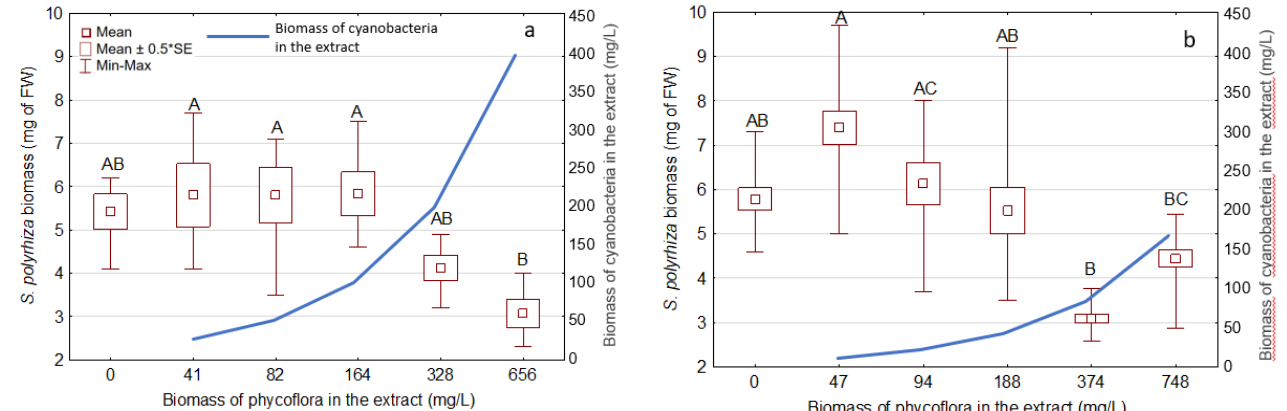
Figure 2. Effect of Phormidium extract ( a ) and Oscillatoria extract ( b ) on the fresh biomass of S. polyrhiza after 72 h exposure (means ± SE, n = 6, 0 = controls). Different uppercase letters (A, B, C) indicate statistically significant differences between treatments (ANOVA, Tukey’s test, p < 0.05).